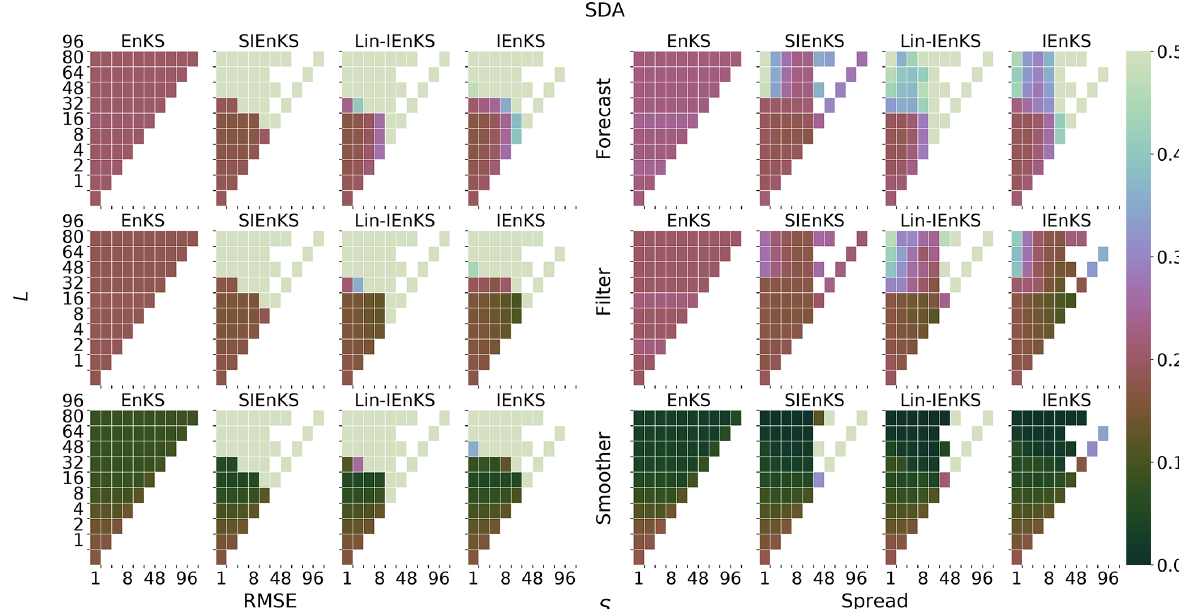
Figure 18. Lag length L on the vertical axis and shift S on the horizontal axis. SDA, tuned inflation, linear observations, ensemble size N e = 21, and (cid:49)t = 0 . 05 are indicated.